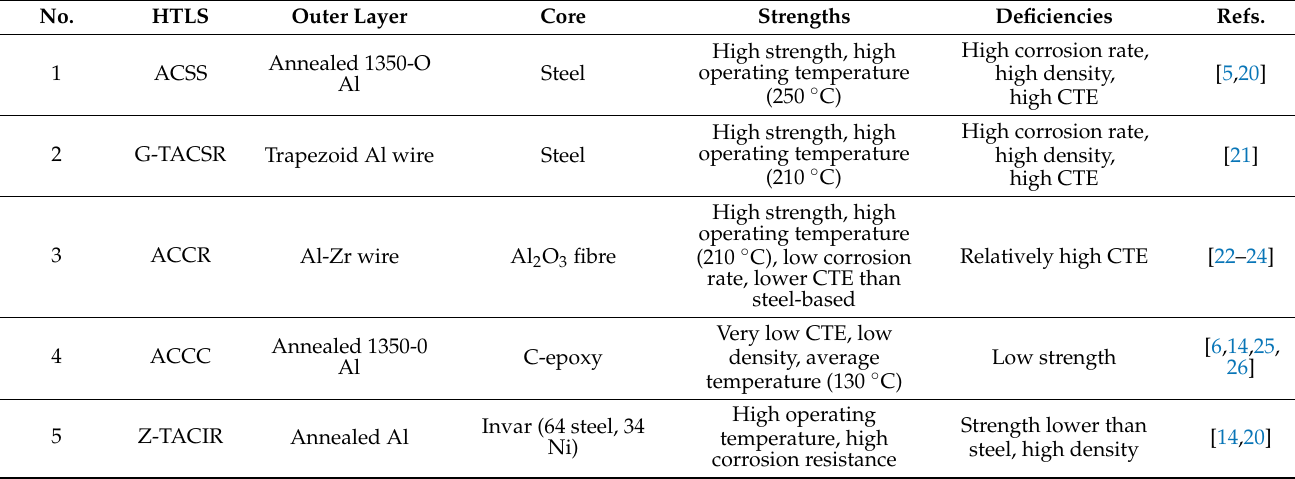
Table 1. HTLS Conductors and their Properties.